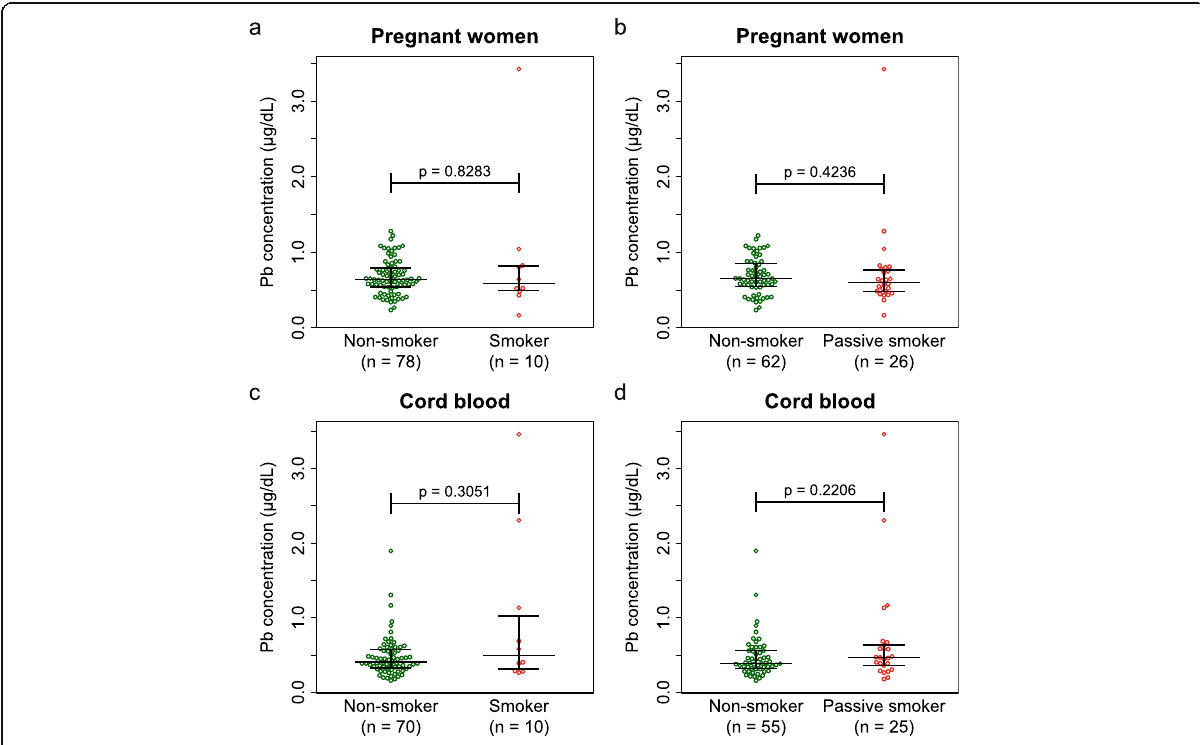
Fig. 3 Smoking experience and passive smoking. Comparison of Pb concentrations in blood of pregnant women ( a , b ), cord blood ( c , d ) between non-smokers and smoking experienced ( a , c ), or between non-smokers and passive smokers ( b , d ). There was no statistical significance in all comparisons (WMW